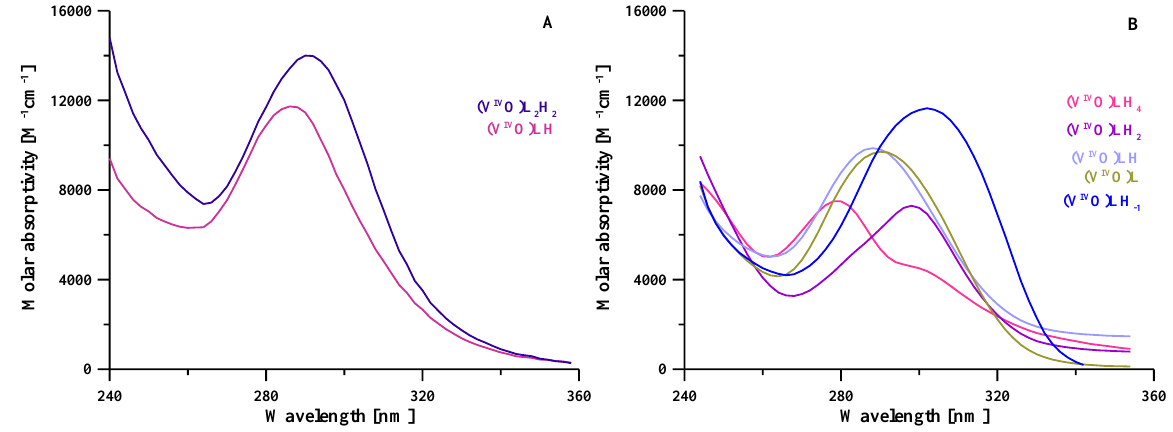
Figure 5. Calculated molar absorptivity spectra of differently protonated forms of V IV O 2+ complexes with L5 ( A ) and KC21 ( B ) ligands.